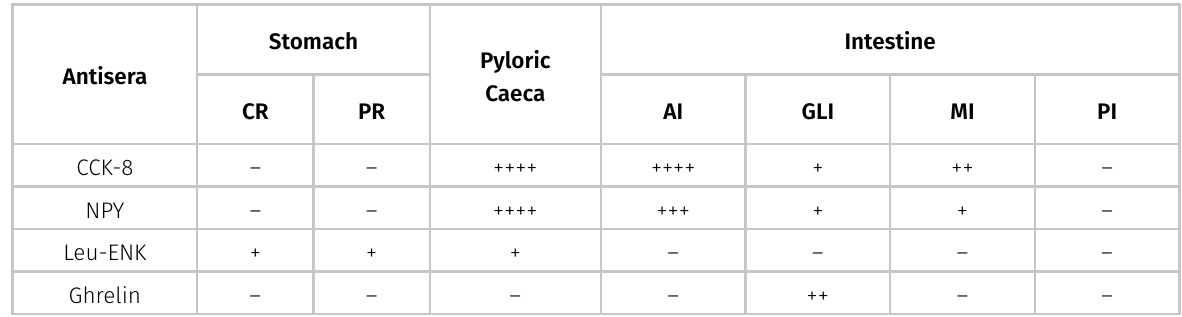
Table II. Regional distribution and immunoreaction intensity of endocrine cells in the digestive tract of Prochilodus lineatus .